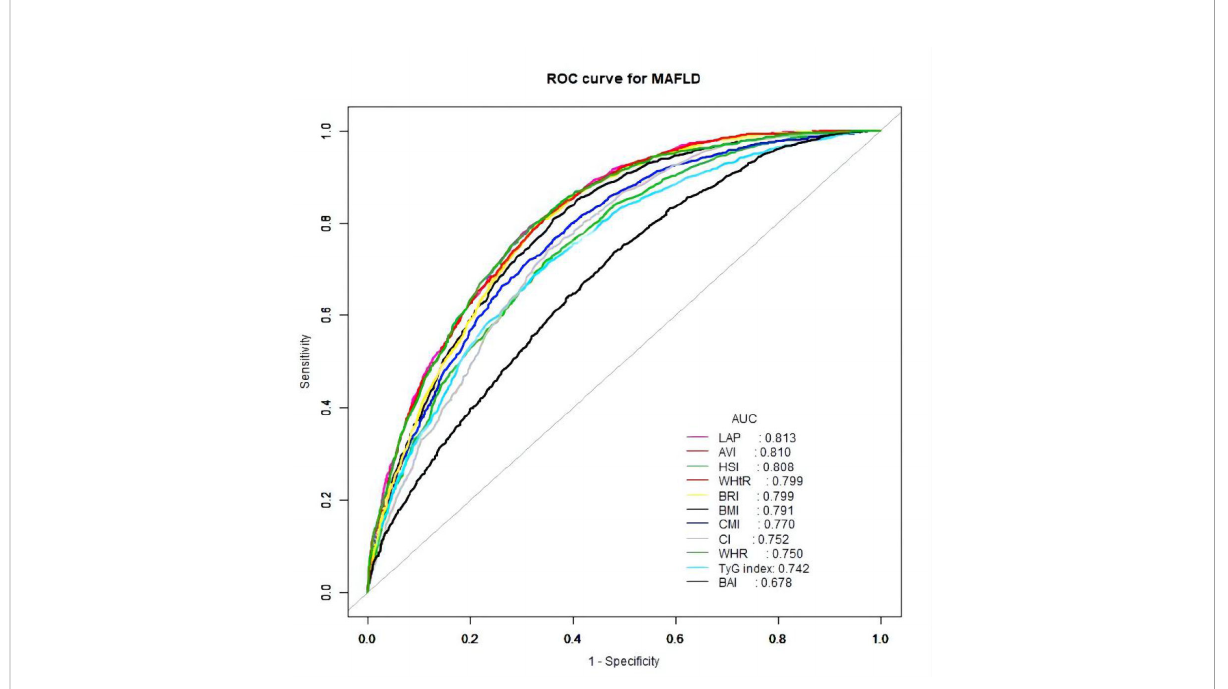
FIGURE 2 Receiver operator characteristic for anthropometric indices in diagnosing MAFLD.